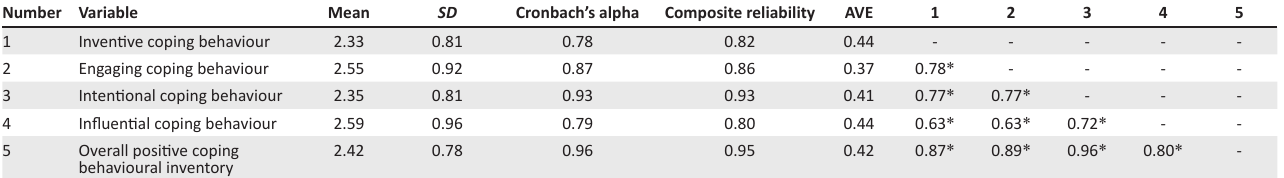
TABLE 2: Descriptive statistics: Means, standard deviations, reliability coefficients, average variance extracted and bivariate correlations. Number